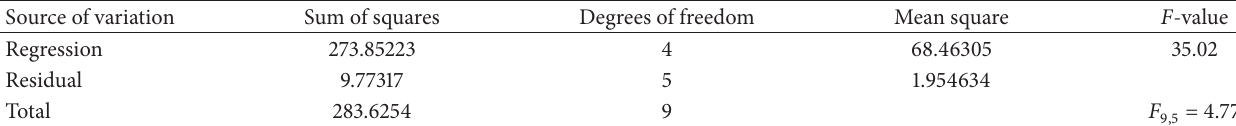
Table 3: ANOVA, analysis of variance, for the conversion of sunflower oil to biodiesel by empirical model of quail eggshell calcined at 900 ∘ C for 3 h.